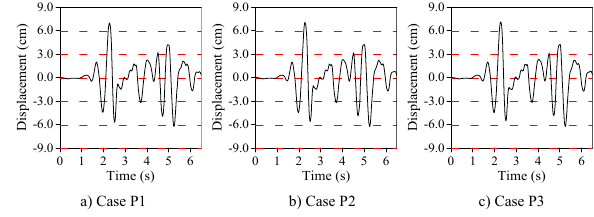
Fig. 12. The time histories of displacements at the nodal point 48 of arch dam for Case P. The variation of maximum and minimum principal stresses along I-I section (Fig. 4) are plotted in Fig. 13 for each case. It can be seen from Fig. 13 that the distribution of the maximum and minimum principal stresses obtained from Case P1, P2, and P3 are similar to each other.